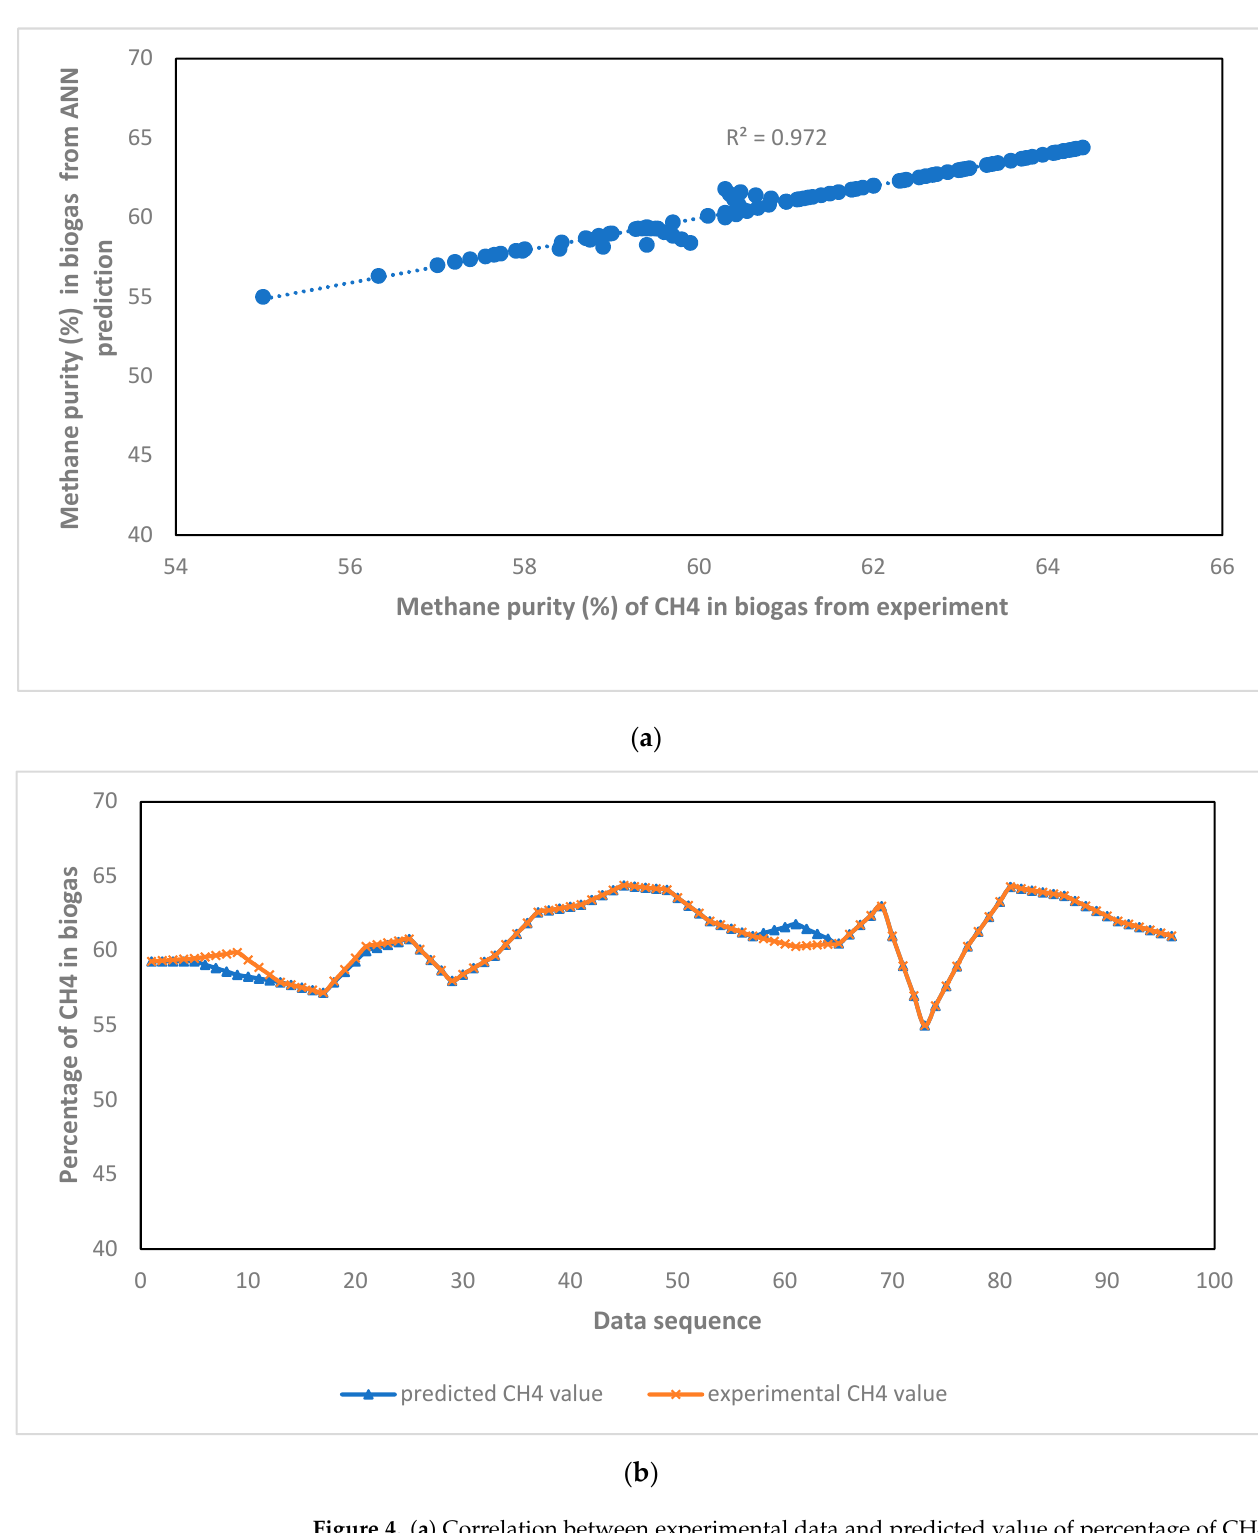
biogas. ( b ) Prediction value and measured data by ANN model for percentage of CH4 in biogas.